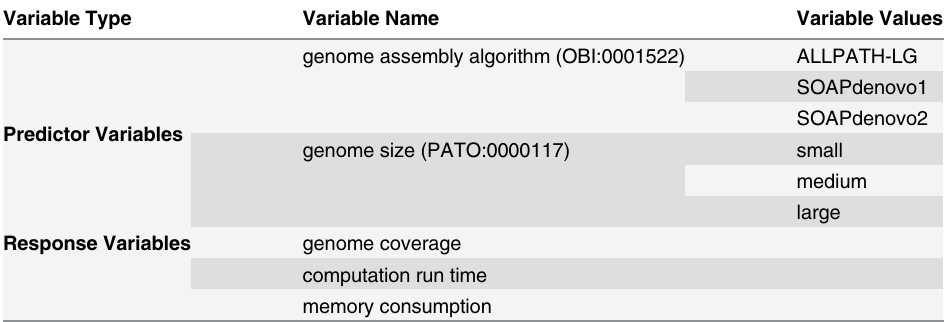
Table 2. Predictor and response variables for the SOAPdenovo2 study, as identified in the ISA-TAB